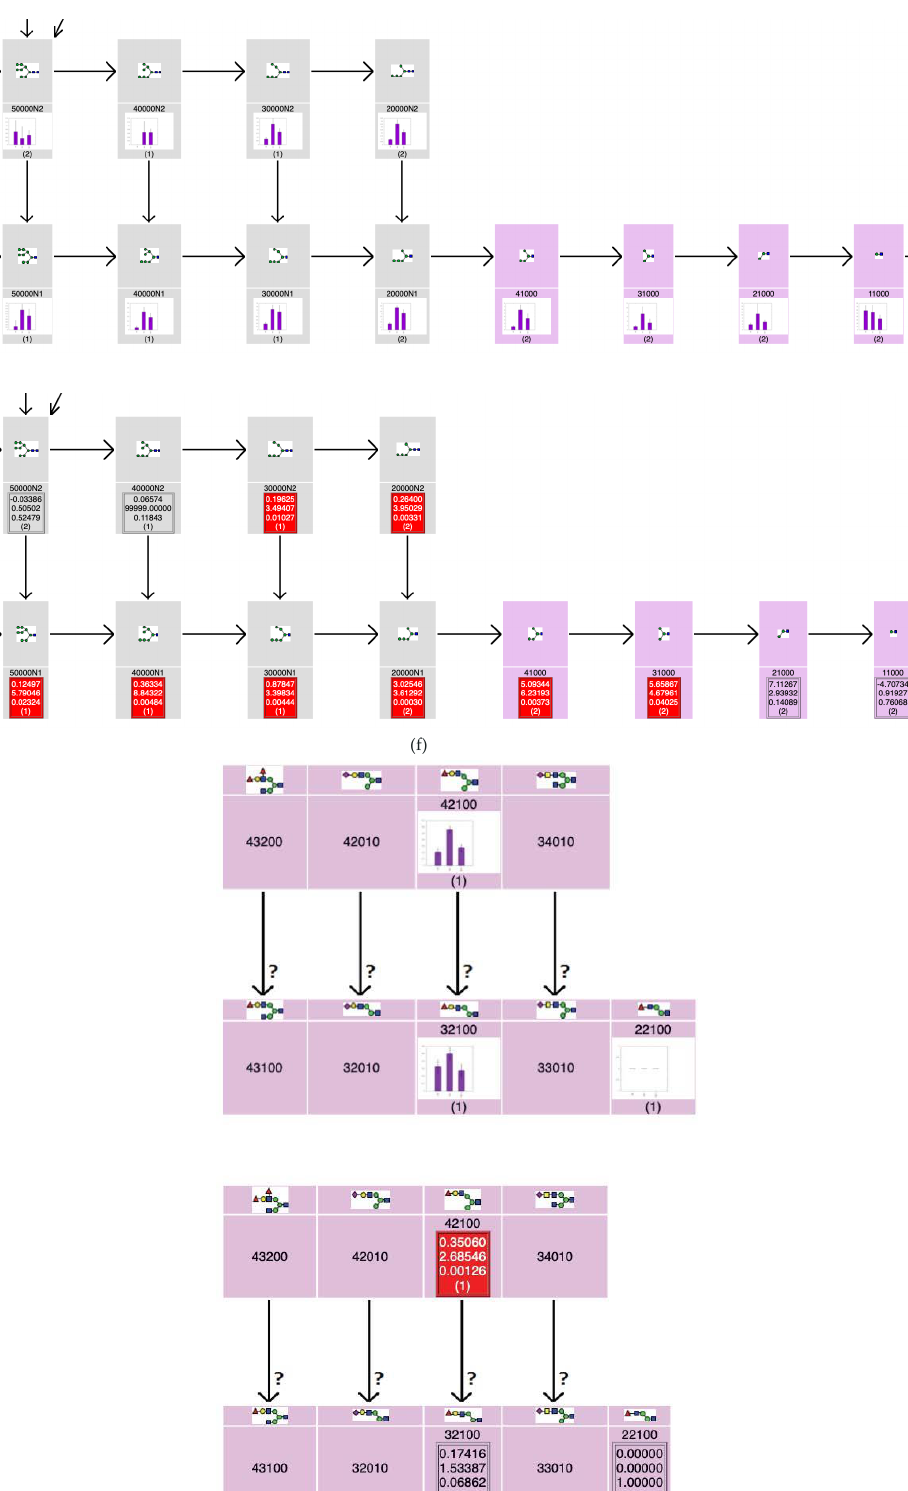
Figure 10. Representative alterations observed among wt(−), NPC(−), and NPC(+) series using bar charts (upper in each panel) and with mean relative abundance and p -value between wt(−) and NPC(−) (lower) for N -glycans and FNGs. ( a ) Expression levels of high (oligo) mannose type (HM) and pauci mannose type (PM) N -glycans. ( b ) Complex biantennary N -glycans. ( c ) Complex triantennary N -glycans. ( d ) Complex tetraantennary N -glycans. ( e ) FNGs possibly derived through the action of pyrophosphatase. ( f ) FNGs possibly derived through the actions of oligosaccharyltransferase (OST) and/or peptide: N -glycanase (PNGase). ( g ) for a part of complex FNGs.